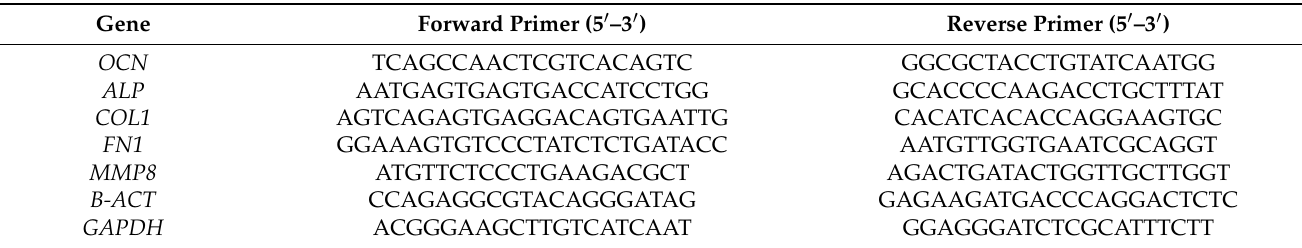
Table 1. Primer sequences used in